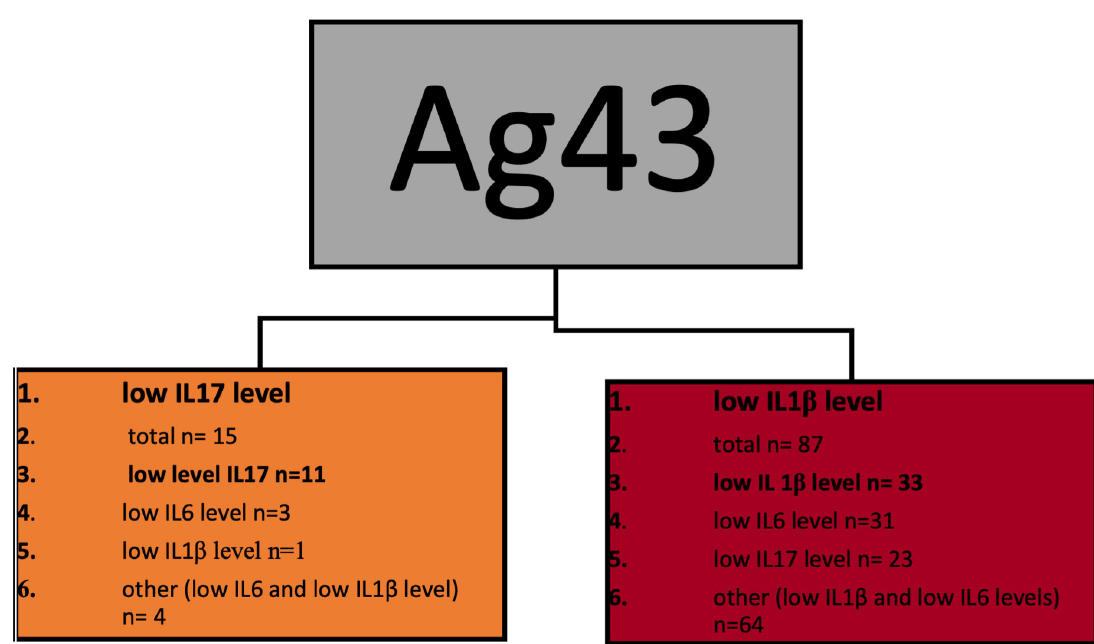
Fig 4. Classification model of low interleukin levels. This model targeted three separate labels: Low IL17 level vs. low IL1 β level vs. low IL6 level . However, the consolided information about labels other than low IL17 have also been presented. Each of the leaves contains the following data: point 1 –dominating label presented in bold, point 2- n- total number of observations classified in this leaf, points 3–5: the numbers of each observations classified in this leaf including the dominating one, point 6- the number of observations other than low Il17 (low IL1 β and low IL6 ) taken together.